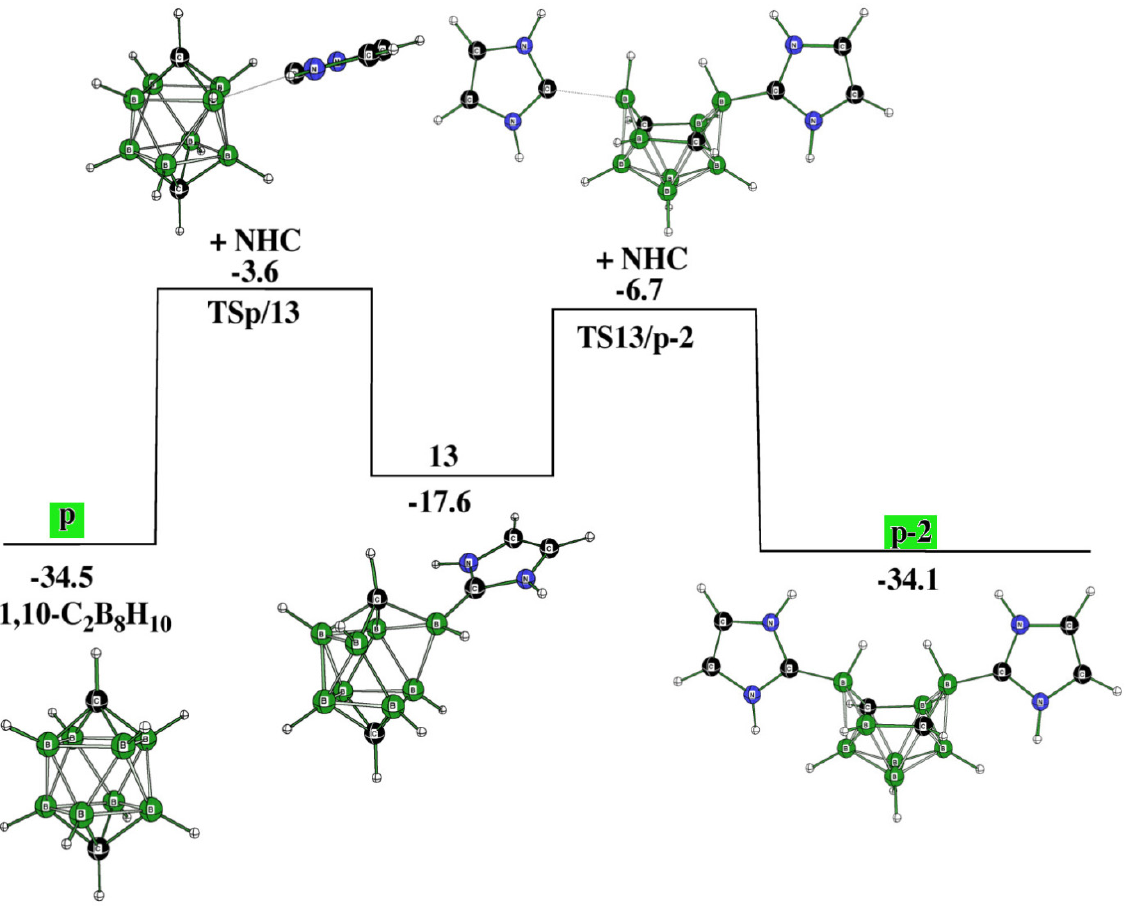
Figure 5. Relative free energies (kcal.mol − 1 ) of the individual stationary points on the potential en